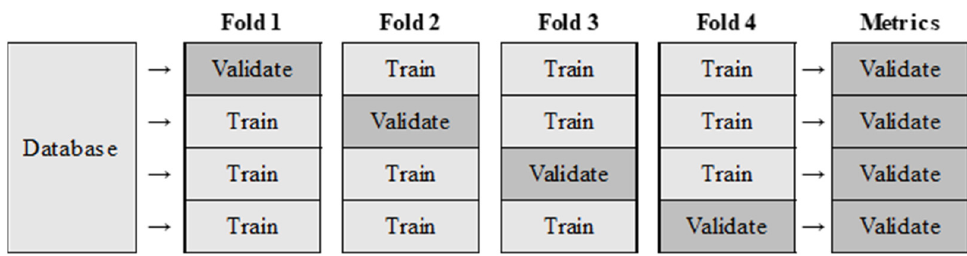
Figure 6. Four-fold cross-validation.